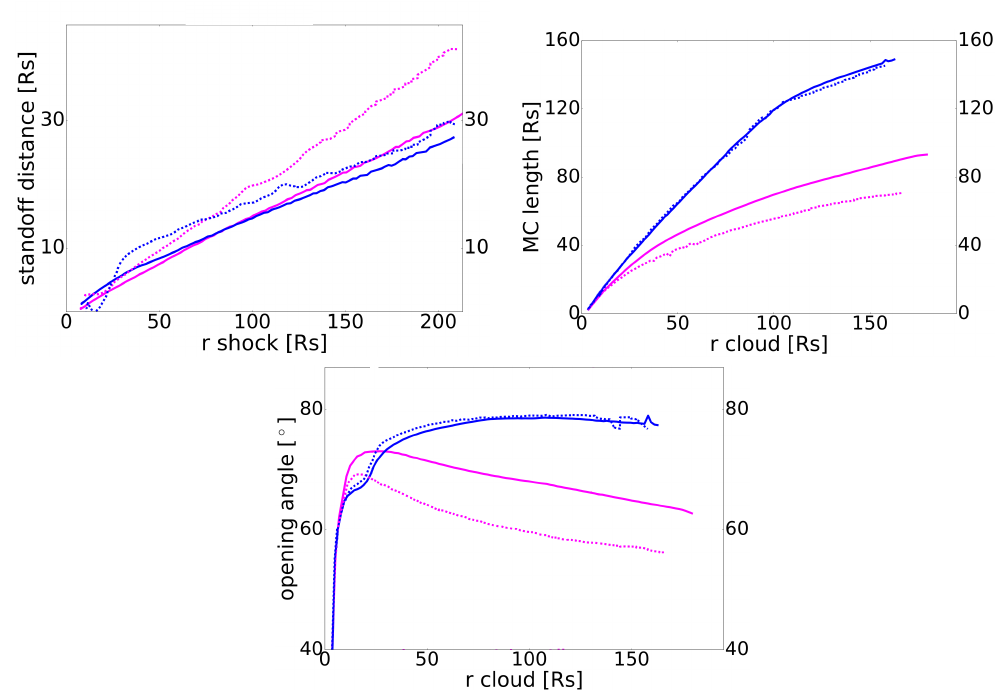
Figure 15. Properties of normal and inverse CMEs ejected in a middle density wind with a medium initial velocity. Magenta and blue lines represent normal and inverse CMEs, respectively, while full and dashed lines represent simulations with and without AMR,